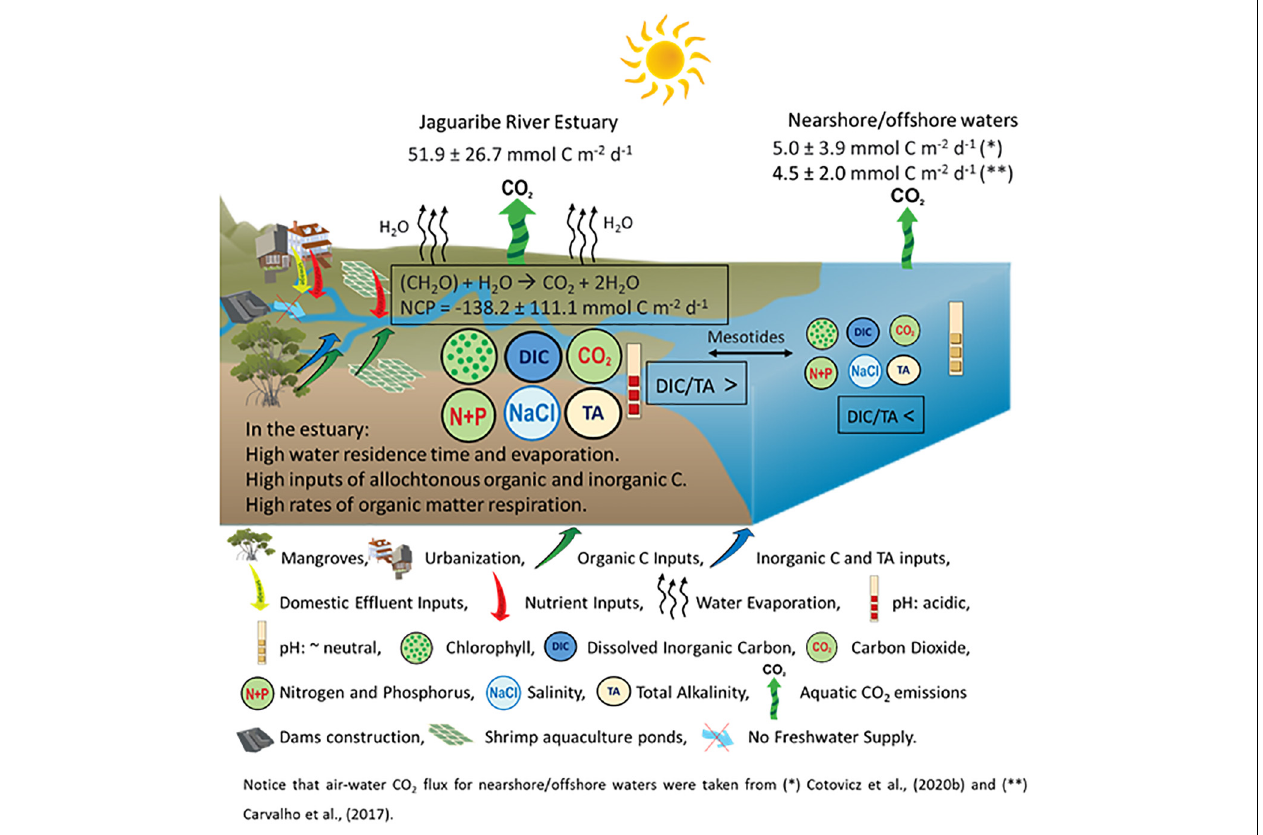
FIGURE 9 | Conceptual model showing the interrelations between semi-arid climate, river damming, eutrophication, and carbonate chemistry in the Jaguaribe River Estuary under dry conditions, and comparison with nearshore waters (Carvalho et al., 2017; Cotovicz et al., 2020b). The larger size of the circles in the estuarine waters represents higher values (for chlorophyll, DIC, TA, CO 2 , nutrients, and salinity) compared to nearshore waters, but are not proportional to measured values.